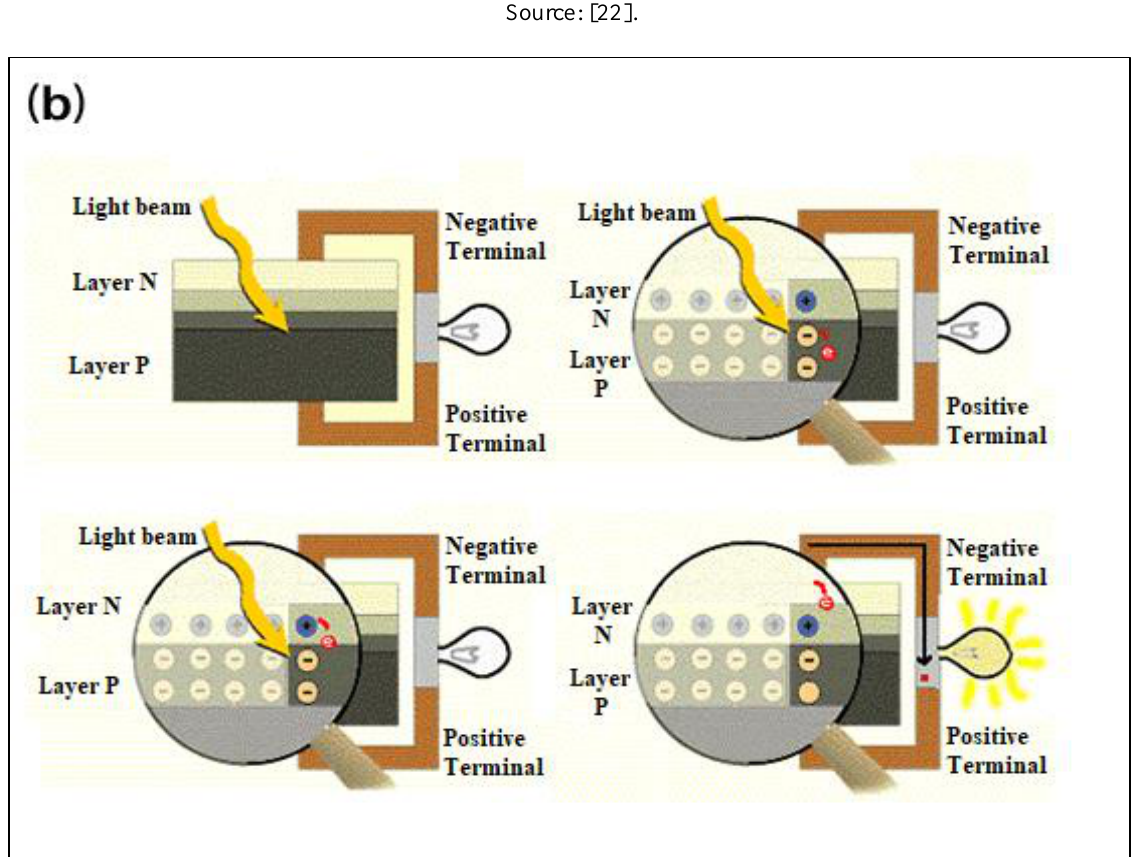
Figure 3b: Operation of a photovoltaic cell. Photovoltaic effect at the P-N junction. Source: